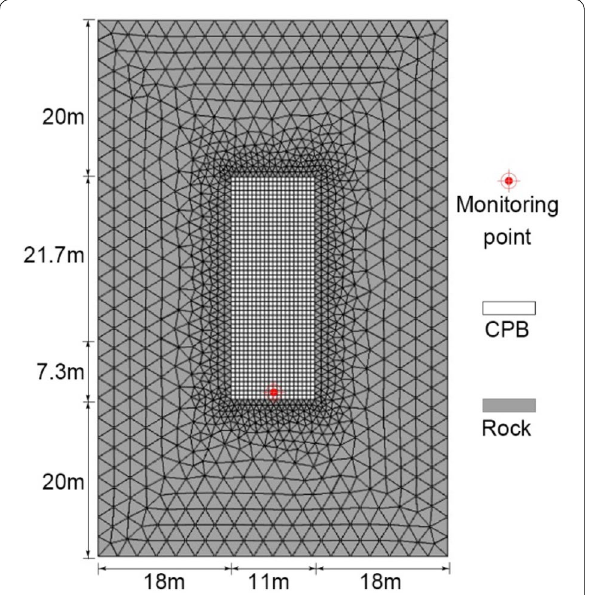
Fig. 5 Mesh and geometry of simulated stope at DG Mine